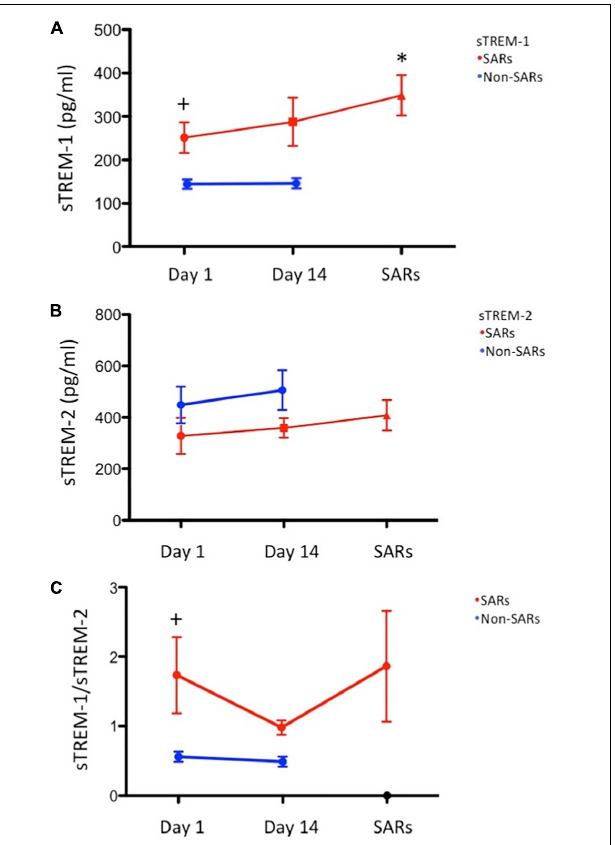
FIGURE 1 | Serial sTREM plasma levels. ( N = 12: systemic adverse reactions (SARs) group; N = 31: non-SARs group): (A) Mean sTREM-1 plasma levels were significantly higher in the SARs group (red circle) than in the non-SARs group (blue circle) on day 1 (P = 0.006). Mean sTREM-1 plasma levels were significantly higher on the day of SARs development (red circle) than that on day 1 (P = 0.003); (B) Mean sTREM-2 plasma levels in the SARs group (red circle) were not significantly higher than in the non-SARs group (blue circle) on day 1; (C) The sTREM-1/sTREM-2 ratio in the SARs group (red circle) was significantly higher than in the non-SARs group (blue circle) on day 1. * P < 0.05 versus day 1 of SAR group, + P < 0.05 versus day 1 of Non-SAR